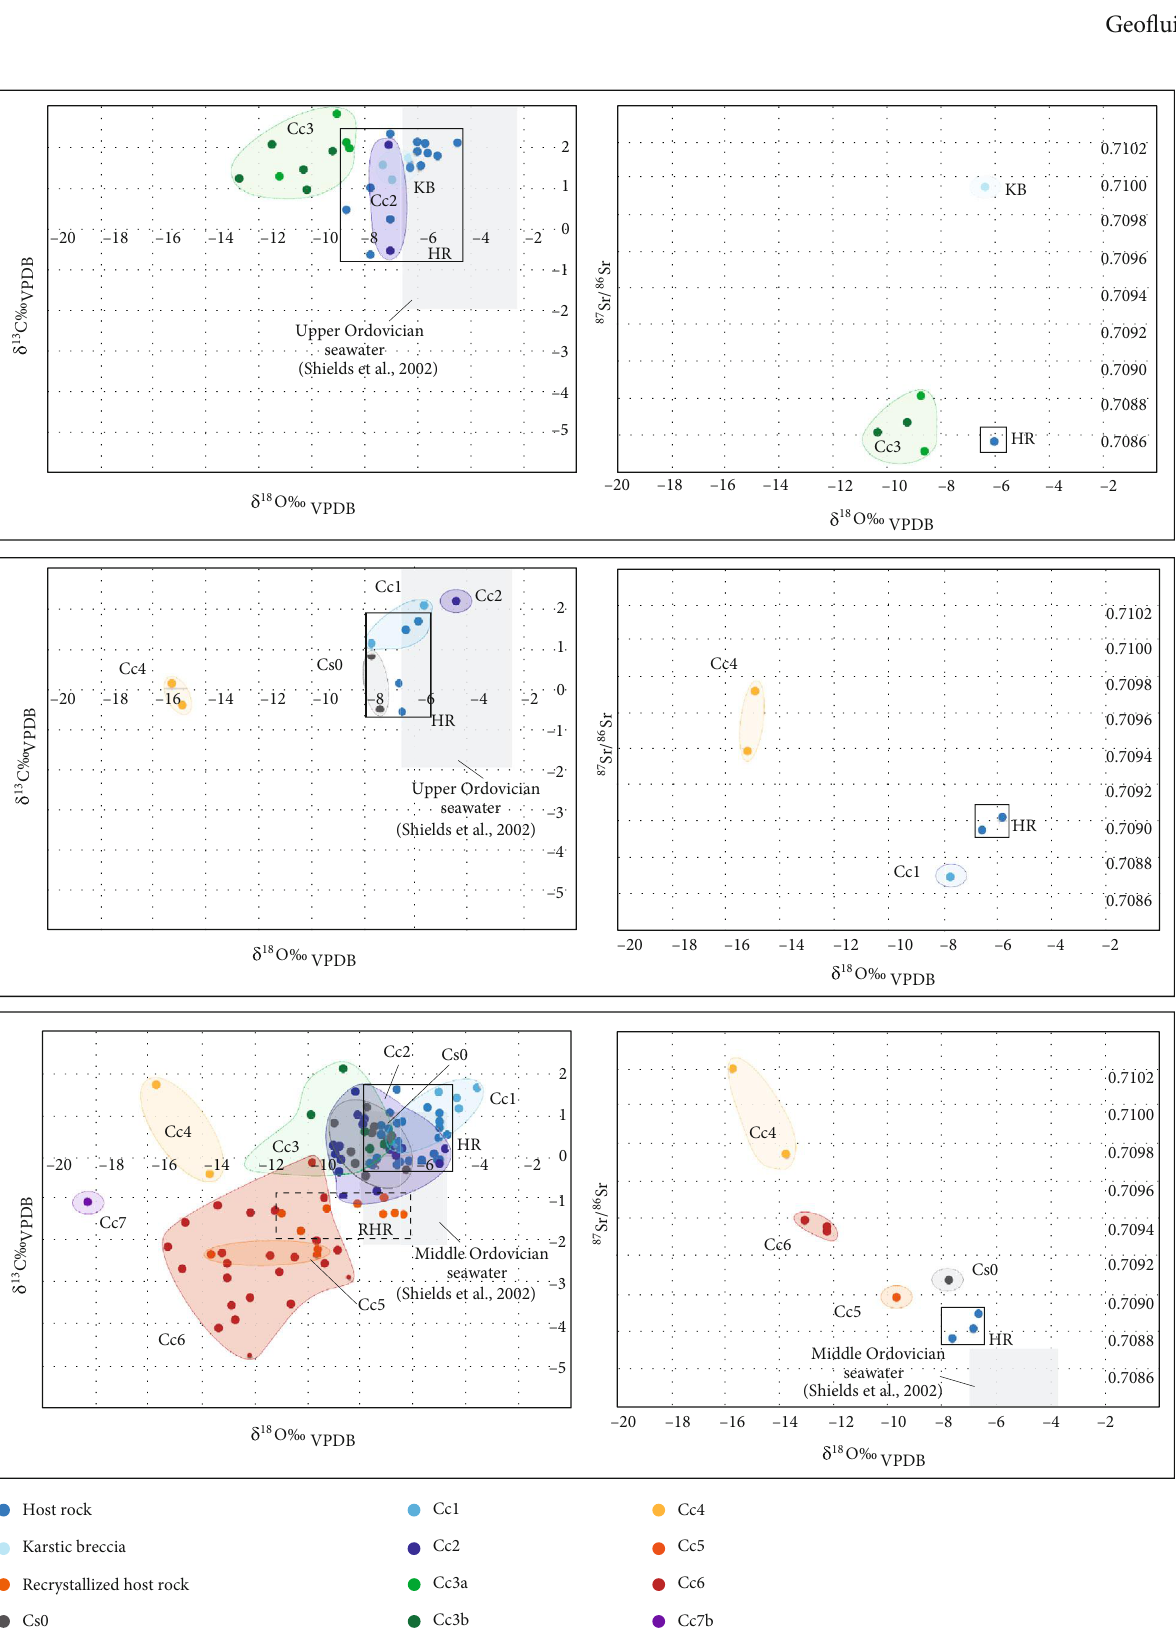
Figure 9: δ 18 O- δ 13 C and 87 Sr/ 86 Sr- δ 18 O crossplots arranged by formation. Light grey polygons show δ 18 O- δ 13 C and 87 Sr/ 86 Sr ranges of Middle Ordovician and Upper Ordovician marine carbonates from Shields et al. [76]. HR: host rock; KB: red-clast karstic breccias; RHR: recrystallized host rock; Cc: calcite cement; Cs: calcite sediment; Dc: dolomite